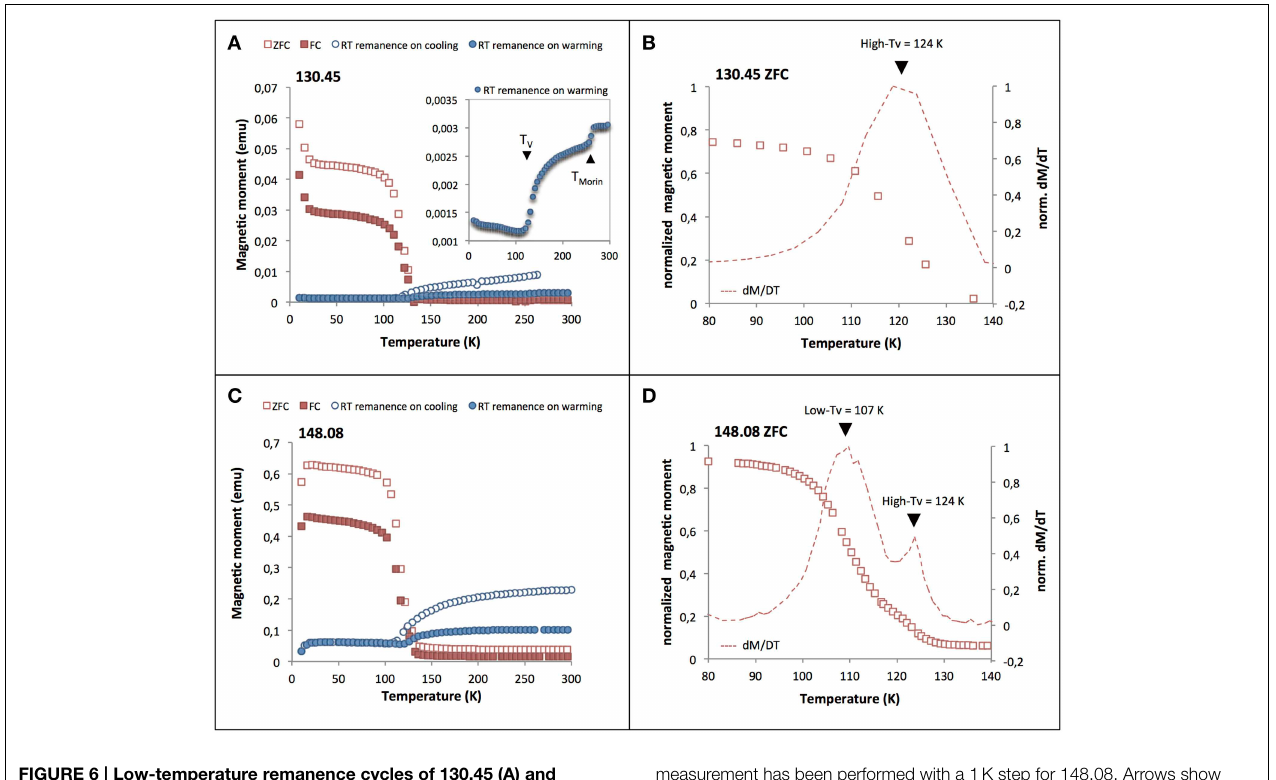
measurement has been performed with a 1K step for 148.08. Arrows show peaks in derivative curve corresponding to T v (130.45: 1 peak corresponding to 1 T v (High-T v ), 148.08: 2 peaks corresponding to 2 T v (Low-T v and High-T v